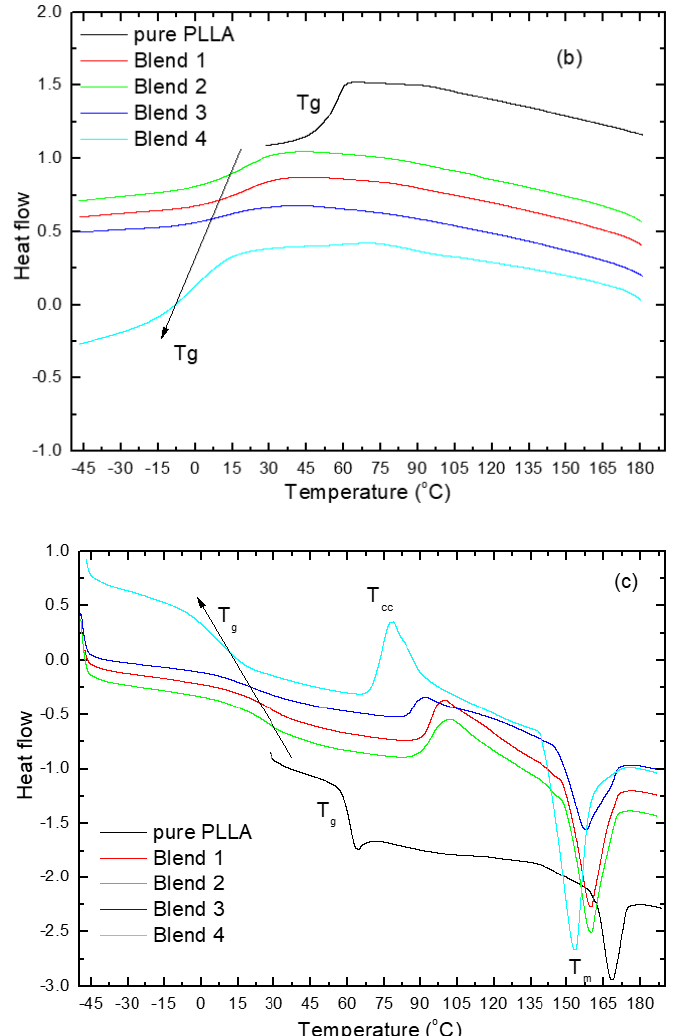
Figure 1. Differential scanning calorimetry (DSC) of pure PLLA and its blends 1,2, 3 and 4: ( a ) the first heating run; ( b ) the cooling from melting; and ( c ) the second heating run. Table 2. Thermal properties of pure PLLA and its blends at different concentrations. F.H.: first heating, S.H.: second heating. Pure PLLA Blend 1 Blend 2 Blend